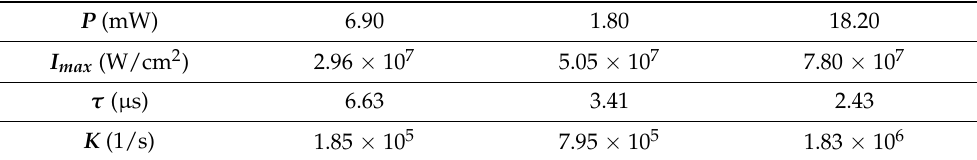
Table 2. Experimental results of τ , peak I (say I max ) and the corresponding photochemical reaction coefficient K in numerical simulation under different P .